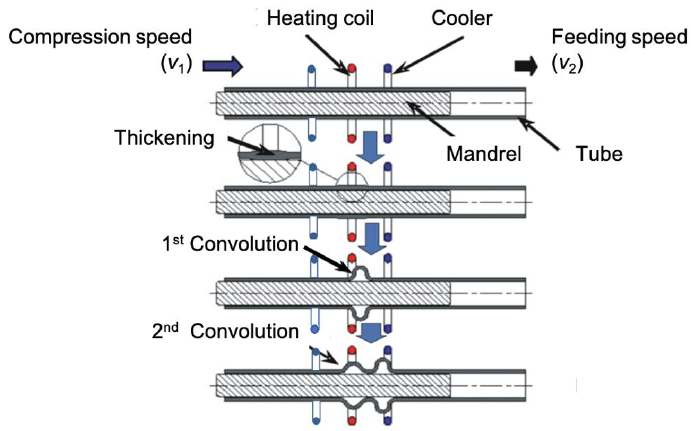
Figure 1. Schematic of the semi-dieless bellows forming with a local heating technique. Deformation mechanism of the semi-dieless forming process is under a free deformation.